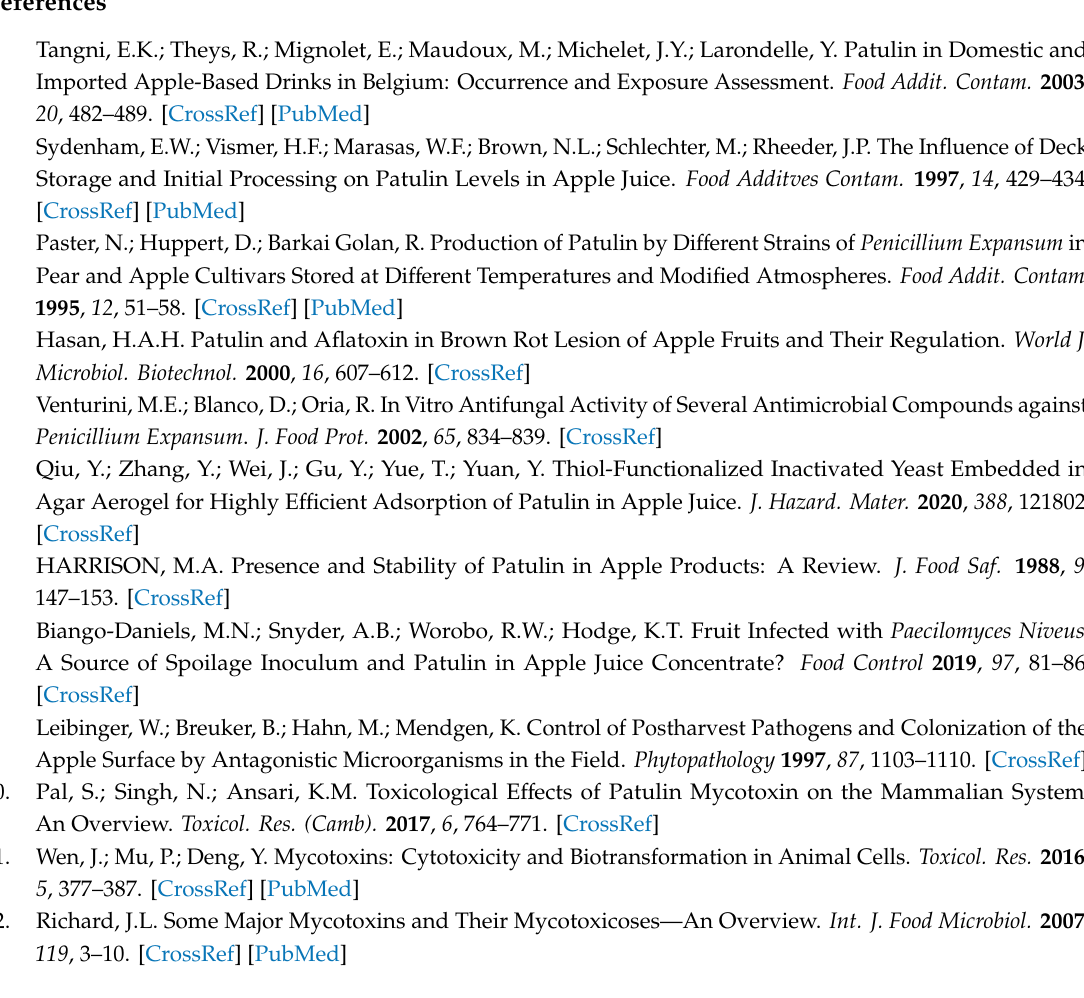
Figure S1: Shows the reaction setup for Fenton oxidation system, Table S1: Concentration of dissolved iron ions at 4-h time